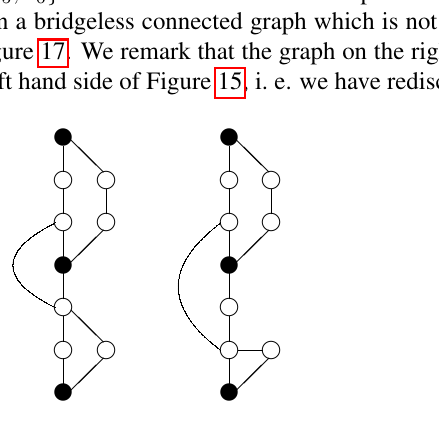
Fig. 17: Extensions for a maximum backbone tree of type 1 in the cases [3 . 6] and [3 . 7]